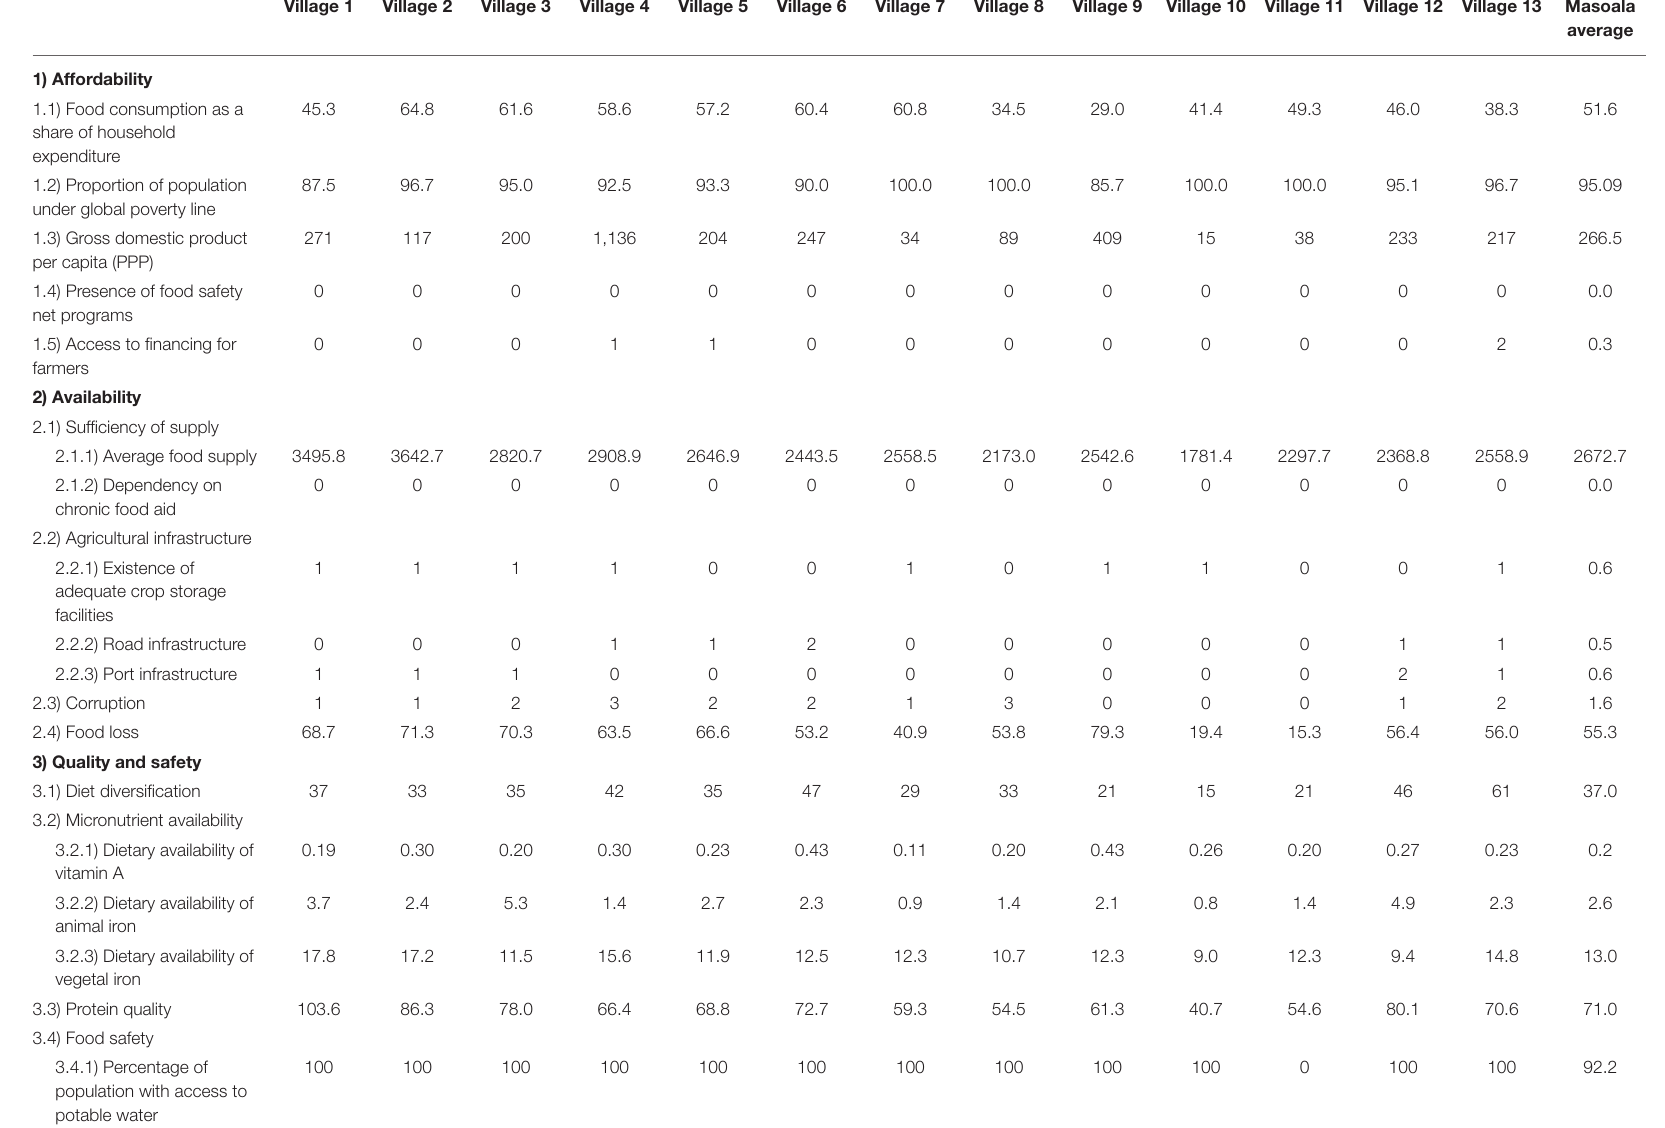
TABLE 1 | Masoala food security (2015) †